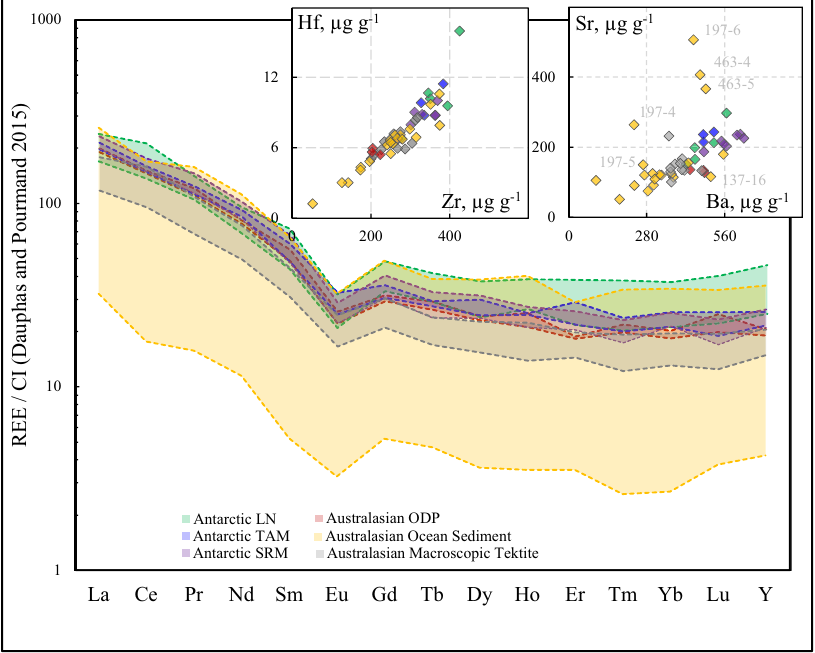
Fig. 2 REE signatures of the tektites and microtektites studied. REE concentrations are normalized to CI-chondrite values 84 . LN Larkman Nunatak, Antarctica, TAM Transantarctic Mountains, Antarctica, SRM Sør Rondane Mountains, Antarctica, Widerøefjellet, ODP microtektites from ocean sediments collected during Ocean Drilling Programs 768B, 769 A and 1144 A, Ocean Sediments – microtektites collected from piston cores during oceanographic studies.